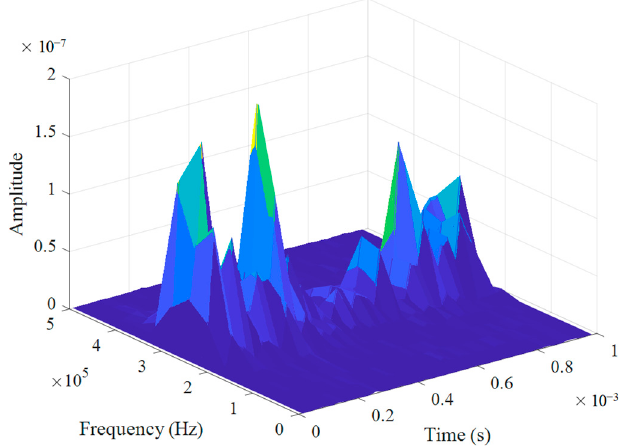
Figure 10. The 3-D spectrogram of the UGW data acquired by FBG.